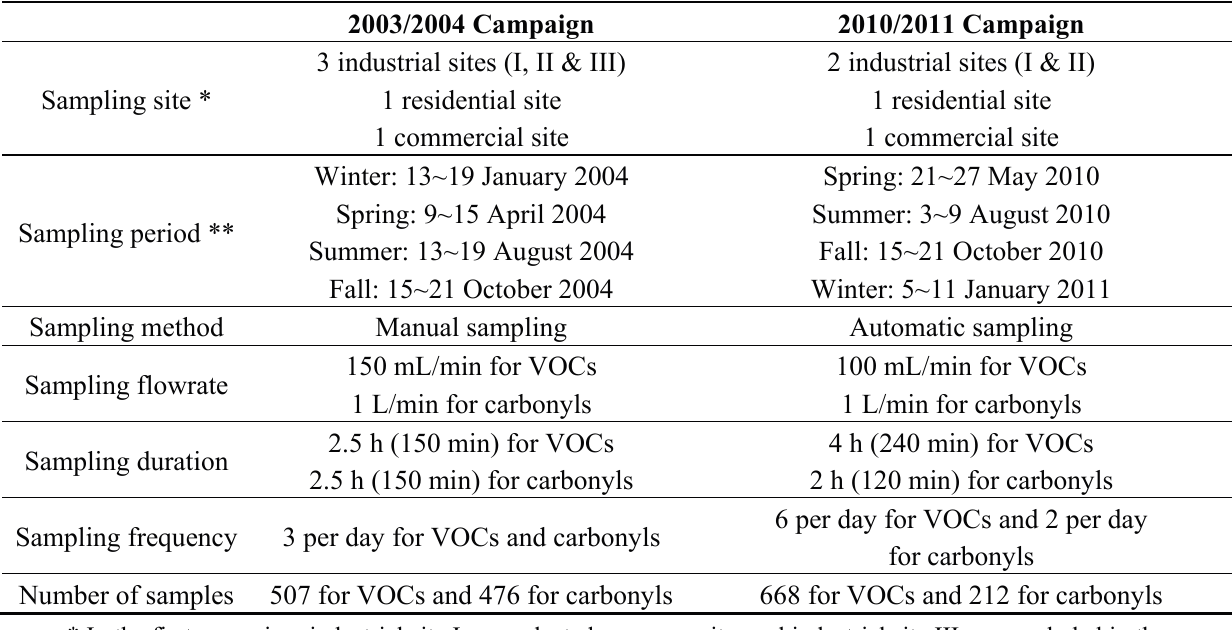
Table 1. Sampling sites and periods for the first and the second